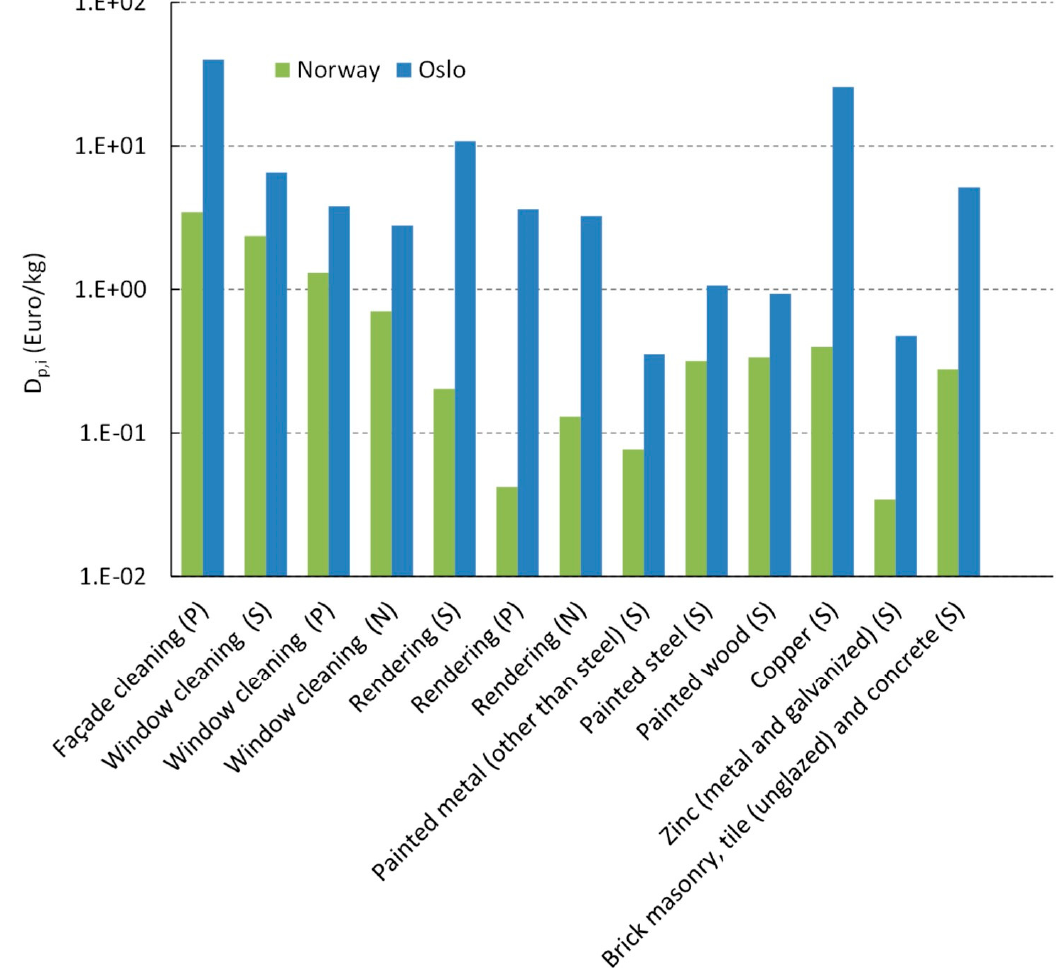
Figure 2. The marginal maintenance cost, D p,i , for the façade materials per kg emission of the air pollutants SO 2 (S), PM 10 (P), and NO 2 (N) (Euro / kg), in Norway and Oslo. The maintenance costs were calculated for the façade and window cleaning and repair operations, given in Table 4. Table 5. Effect slopes, S ERF (p,i), and marginal damage cost, S ERF (p,i) × P and D p,i , due to atmospheric wear of façade materials from air pollution in Norway and Oslo. The maintenance costs and fractions of materials for Norway and Oslo are given, from Table 4, to facilitate the reading of the Table.